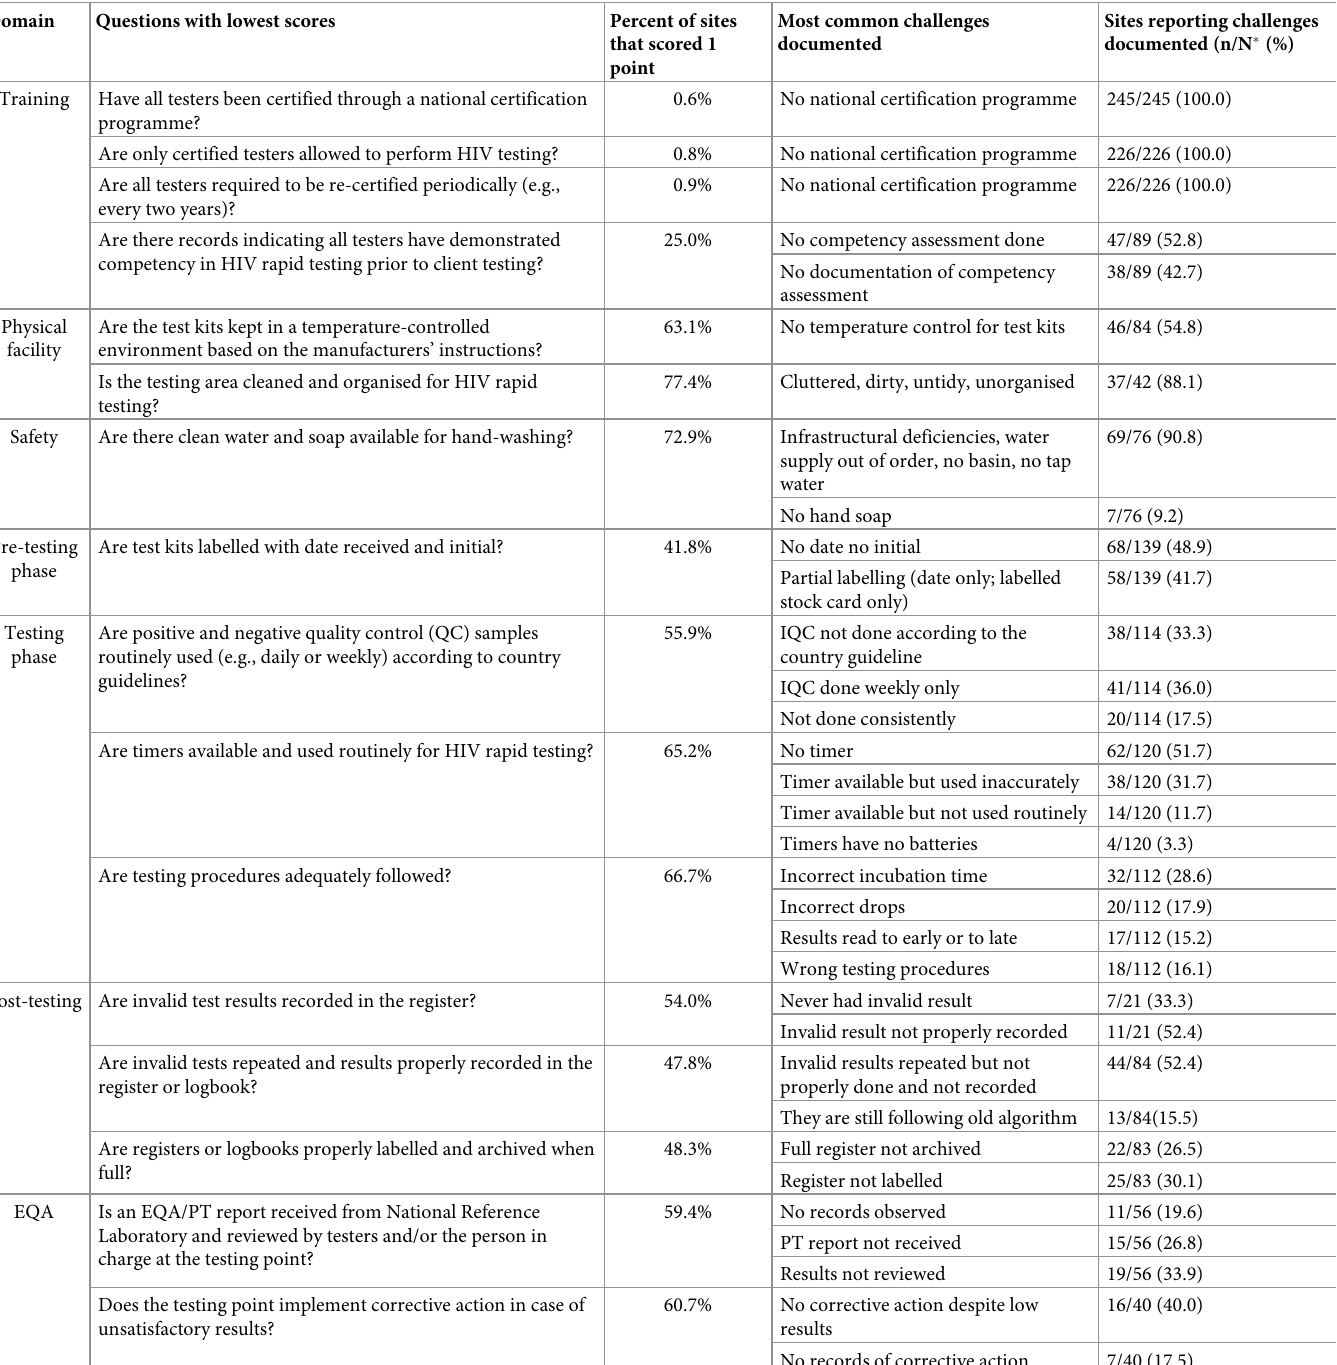
Table 4. SPI-RT checklist question with the lowest score and challenges documented by domain, round-two conducted between 24 November 2016–29 September 17, SPI-RT assessment, South Africa (N = 517).